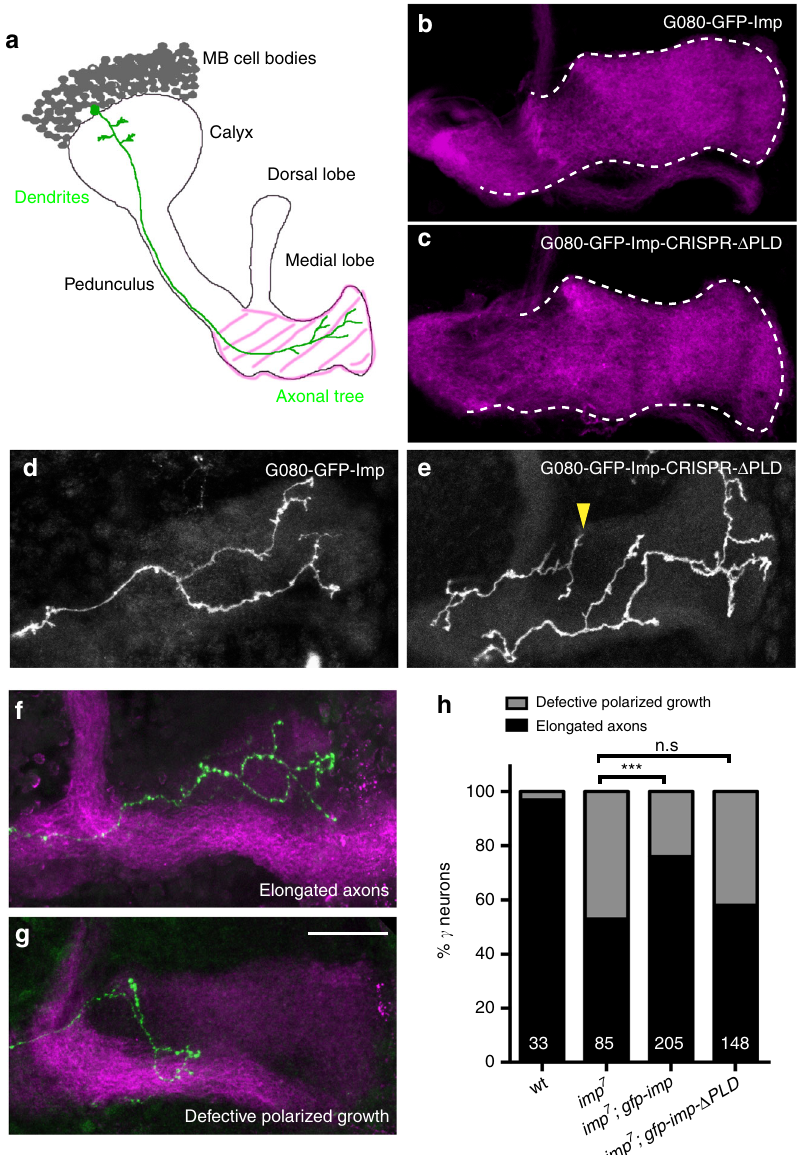
Fig. 2 Imp PLD is required for in vivo axonal remodeling. a Schematic representation of adult Mushroom Body (MB) structure. The medial lobe, which corresponds to the distal part of the γ axon population and is stained in magenta in b , c , f , g , is highlighted with pink stripes. The morphology of a single γ neuron is represented in green. Adapted with permission from 37 . b , c Medial lobes of adult G080-GFP-Imp ( b ) and G080-GFP-Imp-CRISPR- Δ PLD ( c ) MBs labeled with 201Y-Gal4, UAS-RFP. The RFP signal is shown in magenta. d , e Individual γ axons from G080-GFP-Imp ( d ) and G080-GFP-Imp-CRISPR- Δ PLD ( e ) homozygous adult brains labeled with the MCFO technique. The yellow arrowhead points to a not properly elongated γ axon. f , g Representative images of adult MB γ neurons with properly elongated axons ( f ), or showing defective polarized growth ( g ). Single mutant axons were generated and labeled by GFP (green) using the MARCM technique. The medial lobe is stained with FasciclinII (magenta). Scale bar in b – g : 20 μ m. h Percentages of adult γ axons that succeeded (elongated axon) or failed (defective axonal growth) to reach the extremity of the medial lobe. *** P < 0.001 (Fisher ’ s exact test). n. s. stands for not signi fi cant. Numbers correspond to the total numbers of scored individual axons. Source data are provided as a Source Data fi le. Complete genotypes: FRT19A, tub-Gal80, hsp- fl p/FRT19A; 201Y-Gal4, UAS-GFP/ + (wt); FRT19A, tub-Gal80, hsp- fl p/FRT19A imp 7 ; 201Y-Gal4, UAS-GFP/ + ( imp mutant) and FRT19A, tub-Gal80, hsp- fl p/FRT19A imp 7 ; 201Y-Gal4, UAS-GFP/UAS- gfp - imp or UAS- gfp-imp- Δ PLD